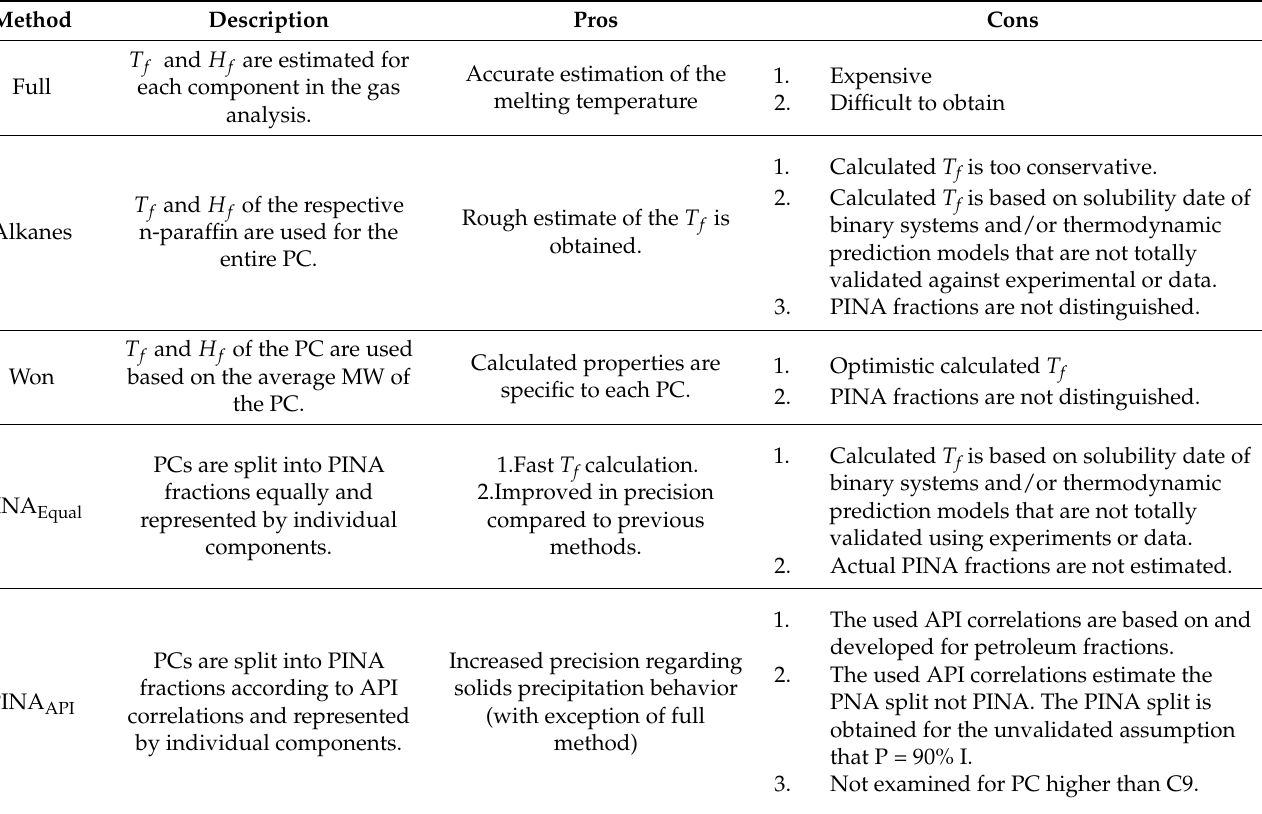
Table 4. Summary and comparison of the available methods of pseudocomponent melting point calculations in natural gas systems [6]. Here, T f is the melting point temperature while H f is the enthalpy of